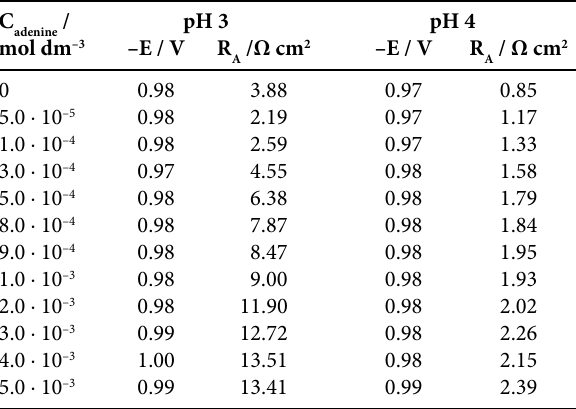
Table 4. Minimal values of activation resistance at given potentials in the system: 5 × 10 –3 mol L –1 Zn(II) in buffer solutions at pH 3 and pH 4 in the presence of increasing adenine